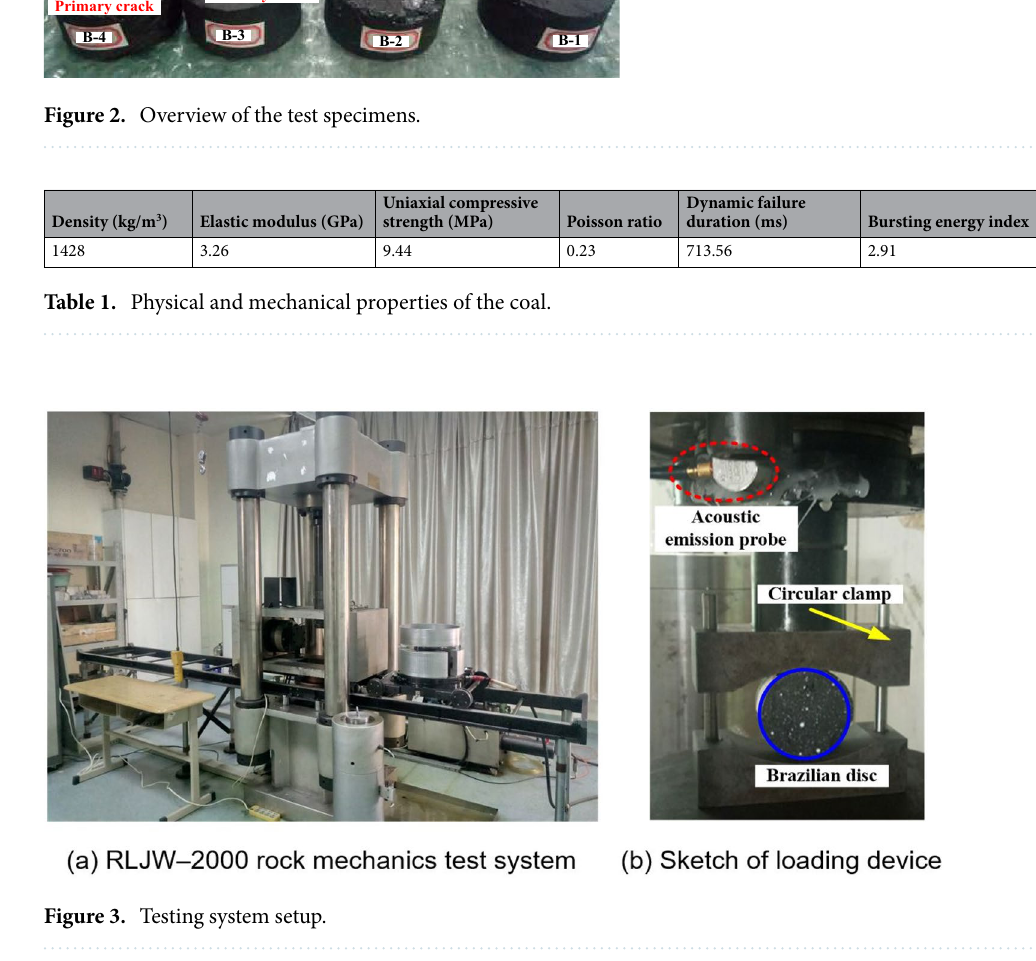
Figure 3. Testing system setup.